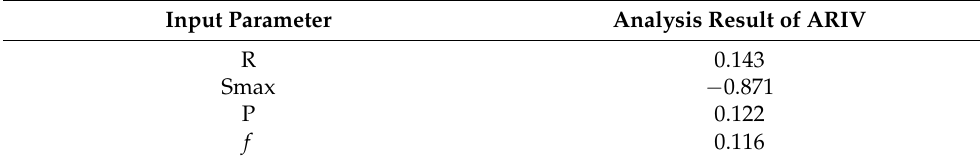
Table 4. ARIV analysis of input parameters for the final BR-BPNN.